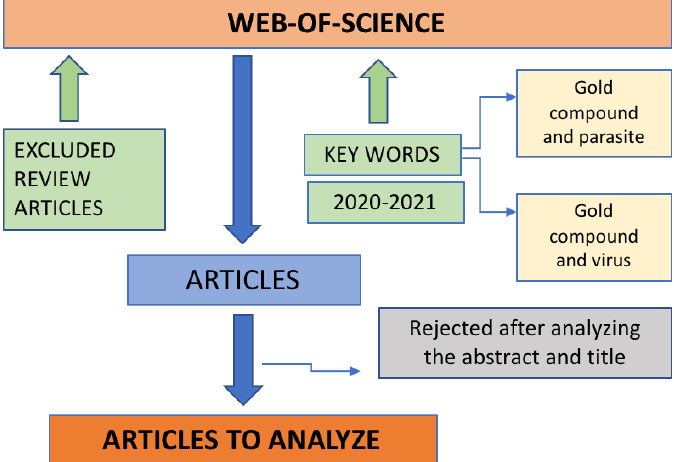
Figure 3. Diagram of the method used to select the articles to be analyzed.